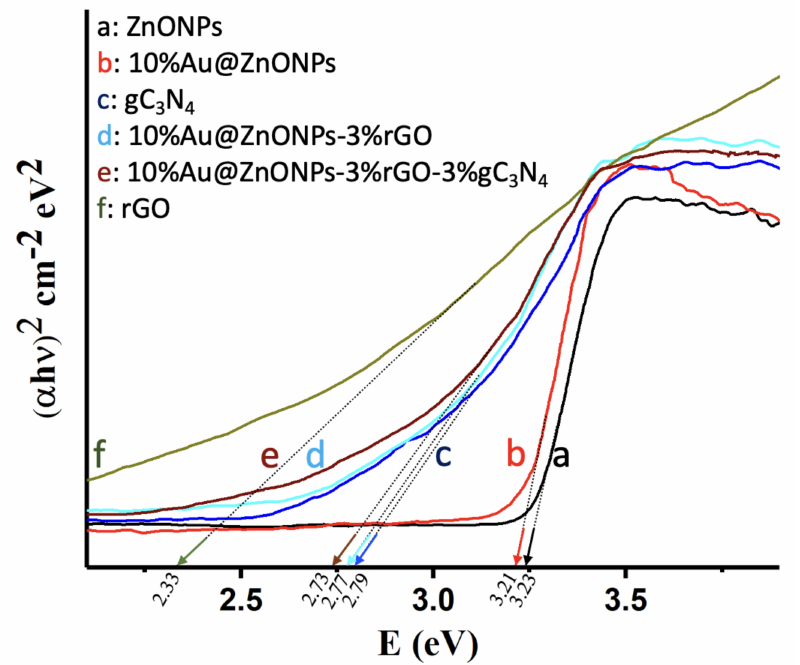
Figure 5. ( a ) Tauc plots of ( α h ν ) 2 versus energy (eV), and determination of the bandgap energy of ZnONPs; ( b ) 10%Au@ZnONPs; ( c ) gC 3 N 4 ; ( d ) 10%Au@ZnONPs-3%rGO; ( e ) 10%Au@ZnONPs- 3%rGO-3%gC 3 N 4 and ( f ) rGO.